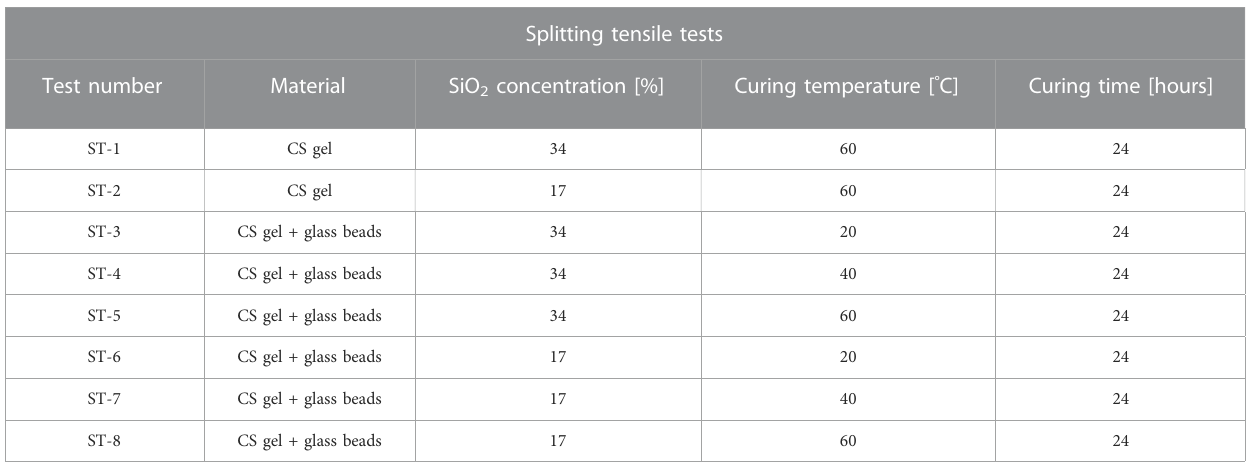
TABLE 1 Summary of splitting tensile (ST) tests for tensile strength